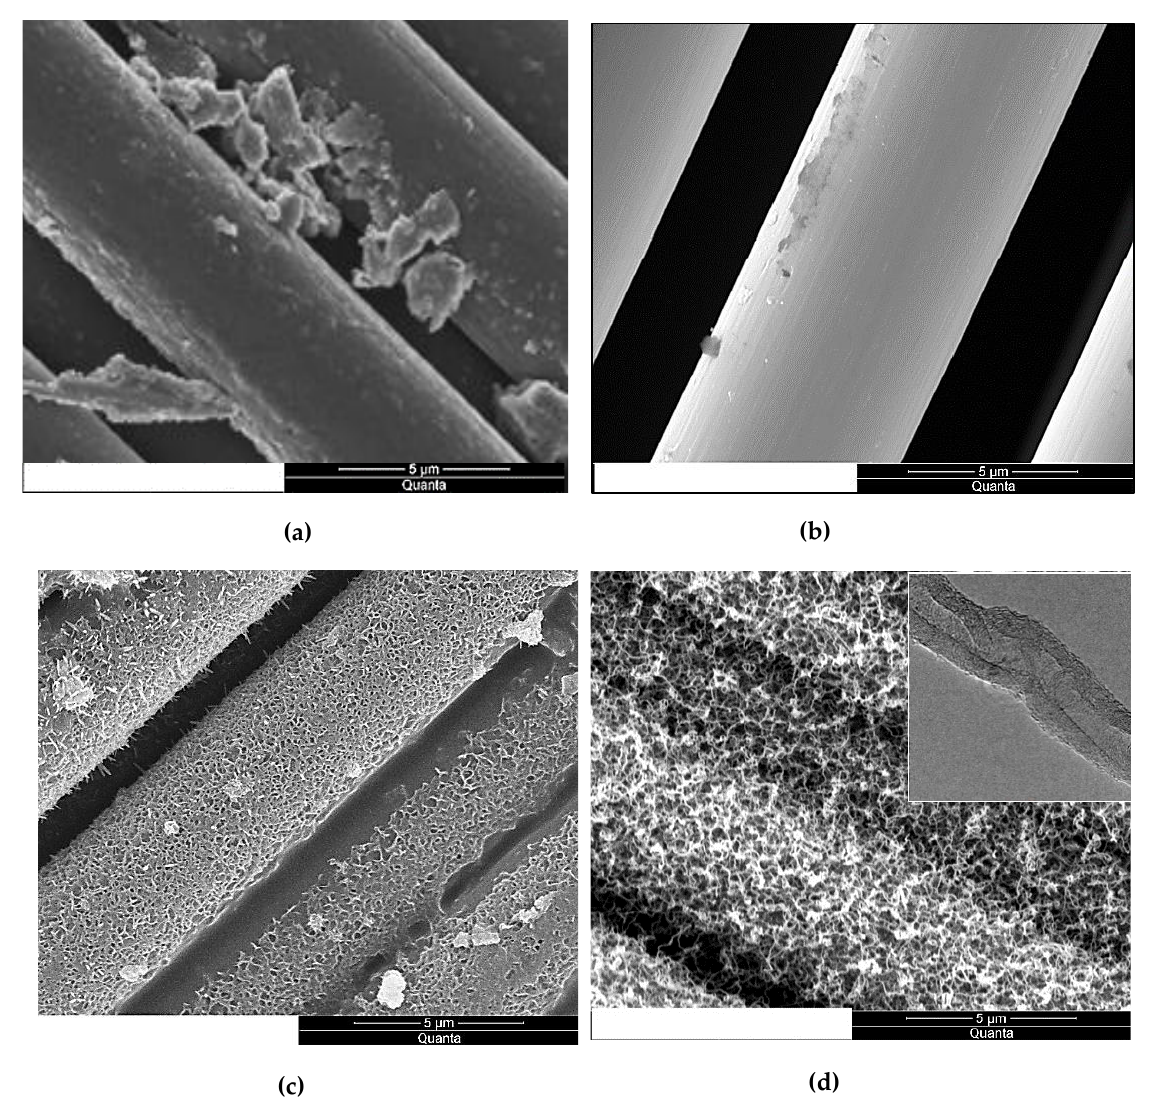
Figure 1. SEM micrographs of ( a ) AS4 de-sized fibers, ( b ) acid oxidized fibers, ( c ) fibers with MOFs growth, and ( d ) fibers with CNTs growth utilizing MOFs as a catalyst. (Inset) TEM micrograph of isolated CNT grown utilizing Ni-MOFs as a catalyst. Table 1. EDS elemental analysis of carbon fibers with MOF, carbon fibers with MOF after reduction under an inert environment, and carbon fibers after growing CNTs.